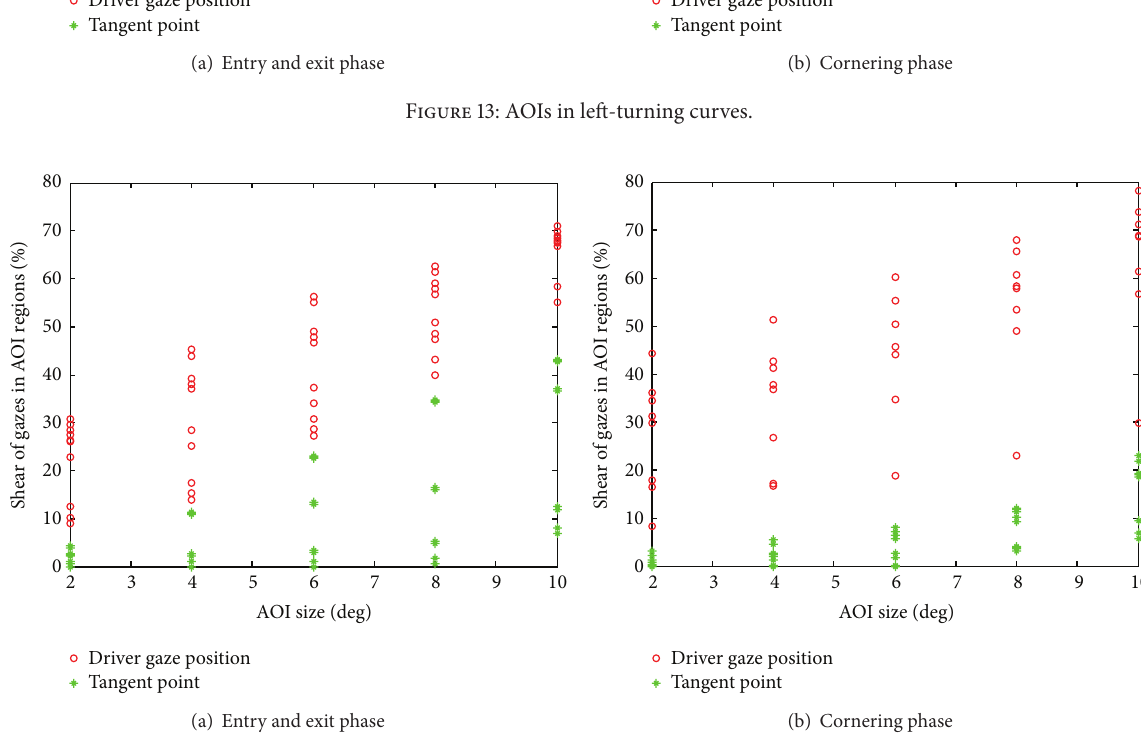
Figure 14: AOIs in right-turning